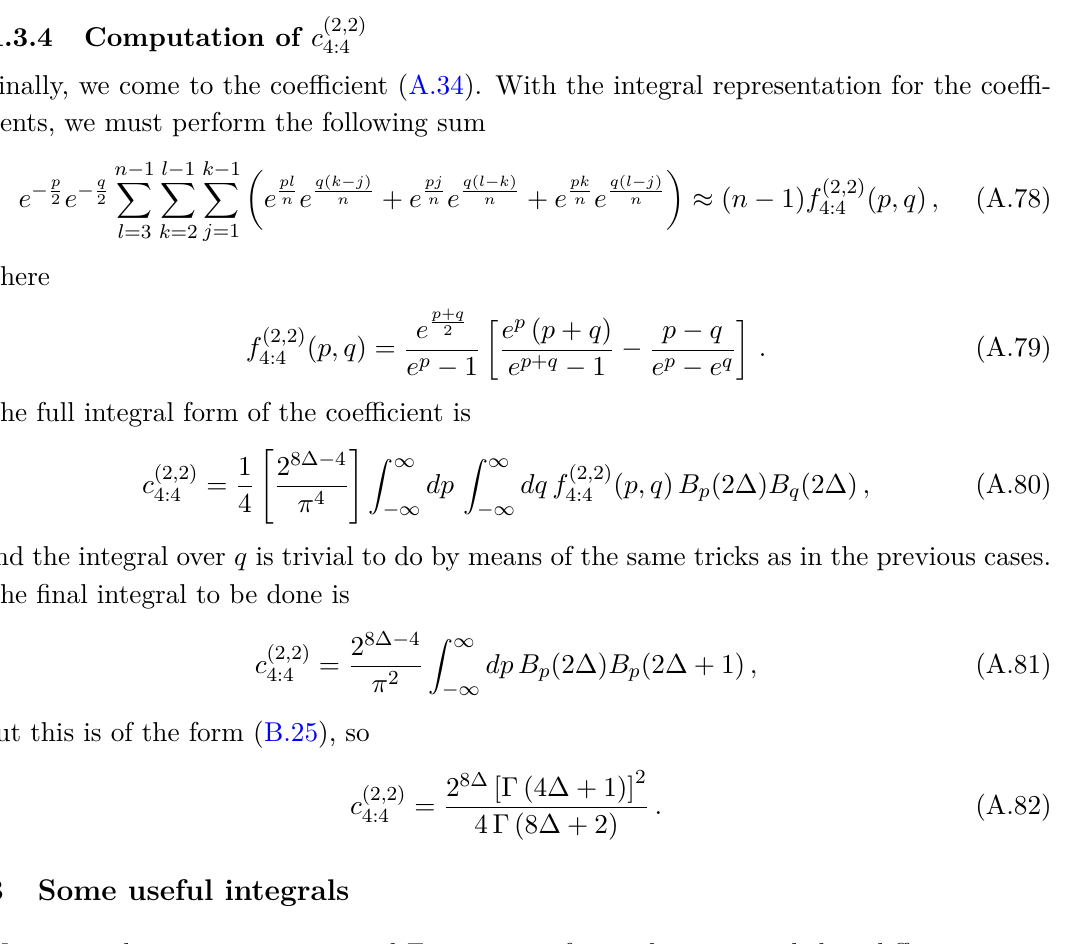
Table 1 . Values of the different terms contributing to c (1 , 1 , 1 , 1) integration of (A.54), while J 2 and J 3 are obtained from the expressions (A.62), (A.64), (A.70), and